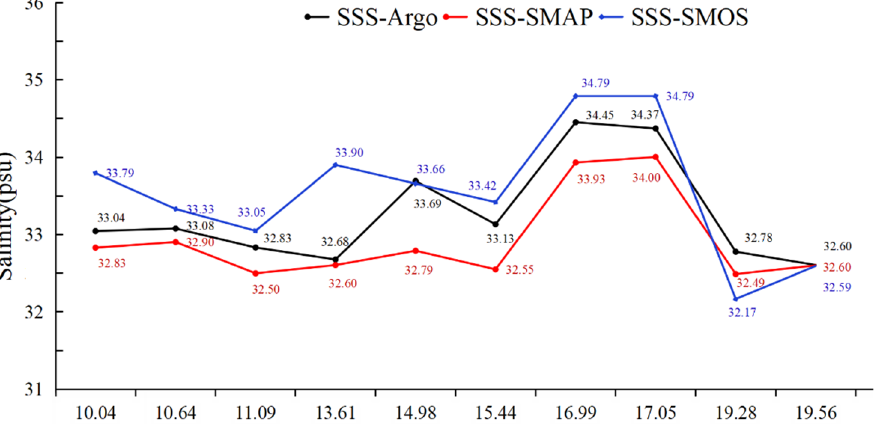
Figure 6. Meridional salinity observations of Argo, SMAP, and SMOS after passage of TC Roanu (2016).